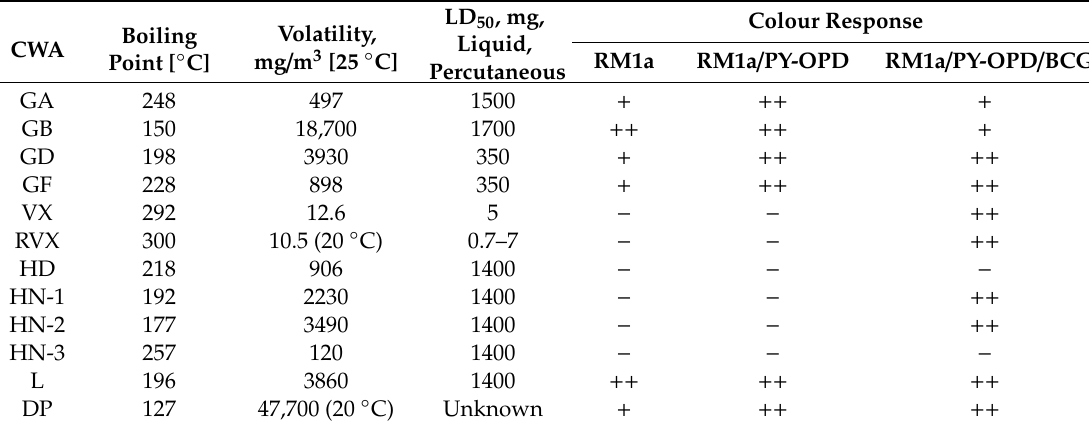
Figure 1. Chemical structure of chemical warfare agents (CWA). Table 1. The summary of tested CWAs, their physical and toxic properties and reactions with detection papers ( − no response, + distinct response, ++ strong